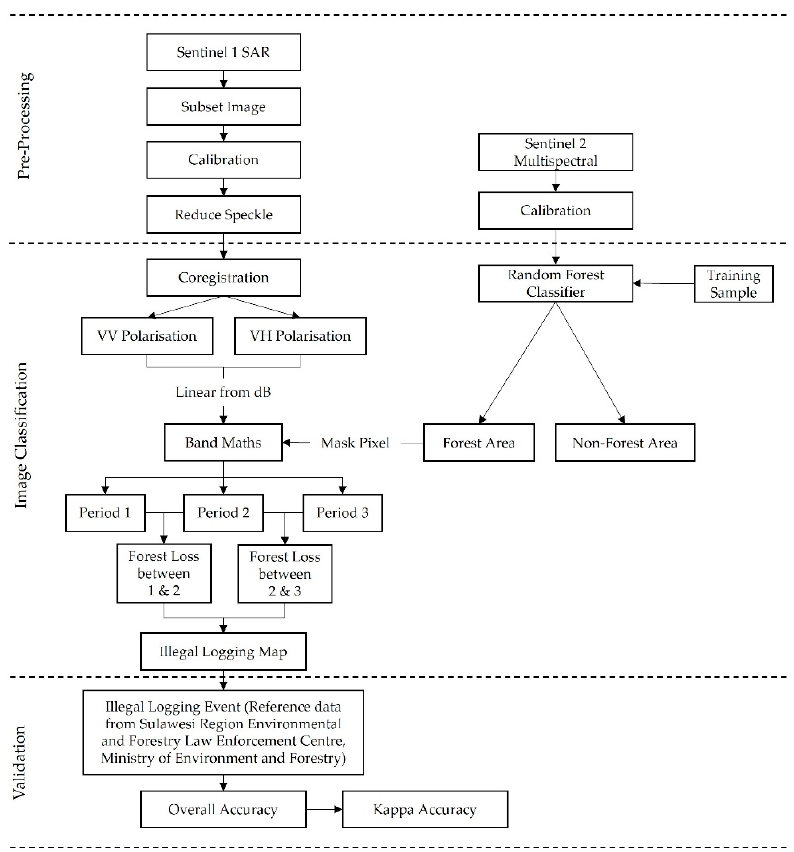
Figure 3. Research framework for illegal logging mapping.